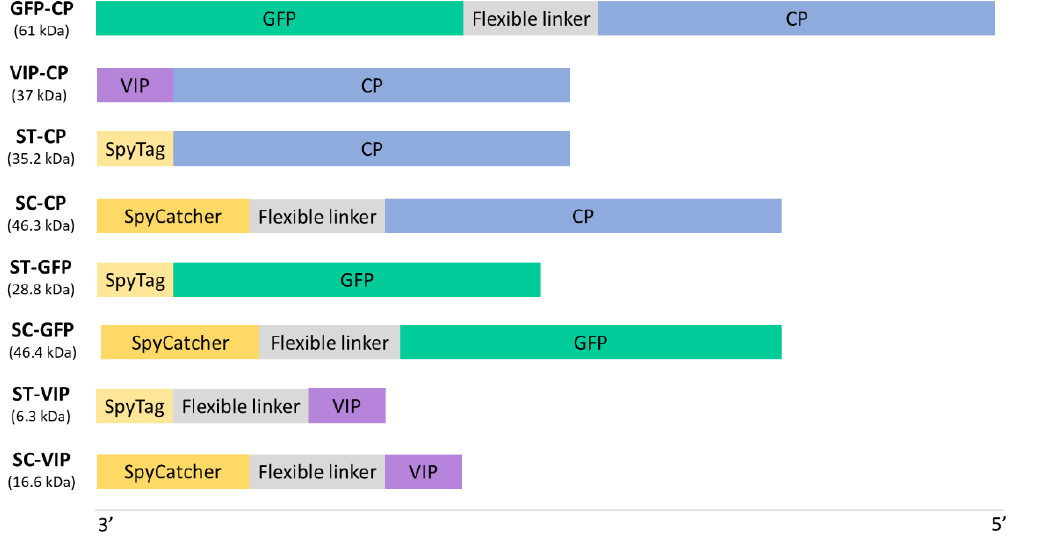
Figure 1. Schematic representation of the eight gene constructs created in this study. A flexible linker (GGGGSGGGGSGGGGS) was added to physically separate the two parts of the fusion protein in those constructs where steric hinderance may happen. ST: SpyTag; SC: SpyCatcher; CP: TuMV capsid protein; GFP: green fluorescent protein; VIP: vasoactive intestinal